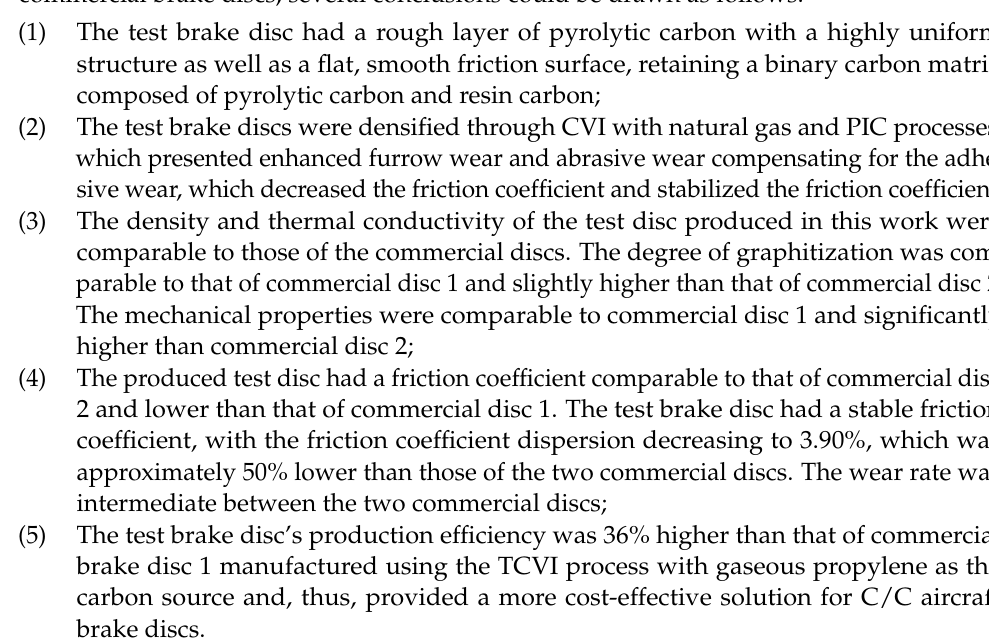
Number of Linear Experiments